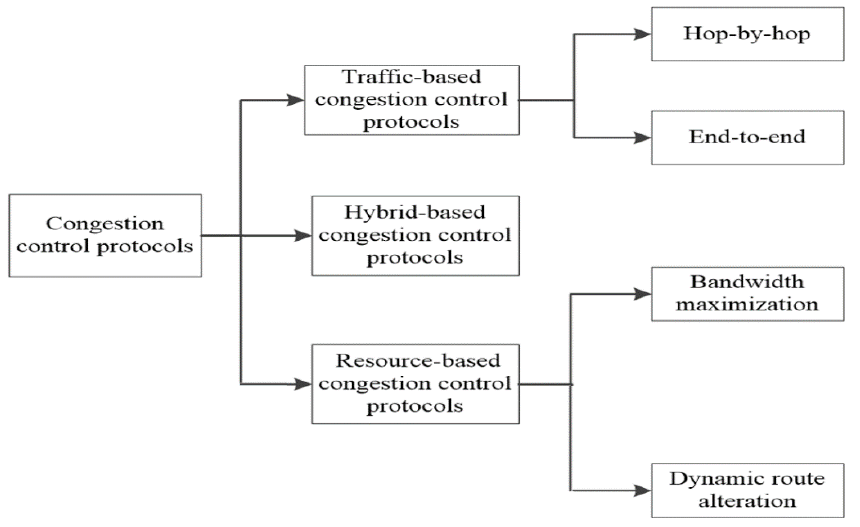
Figure 2. Congestion control protocols.